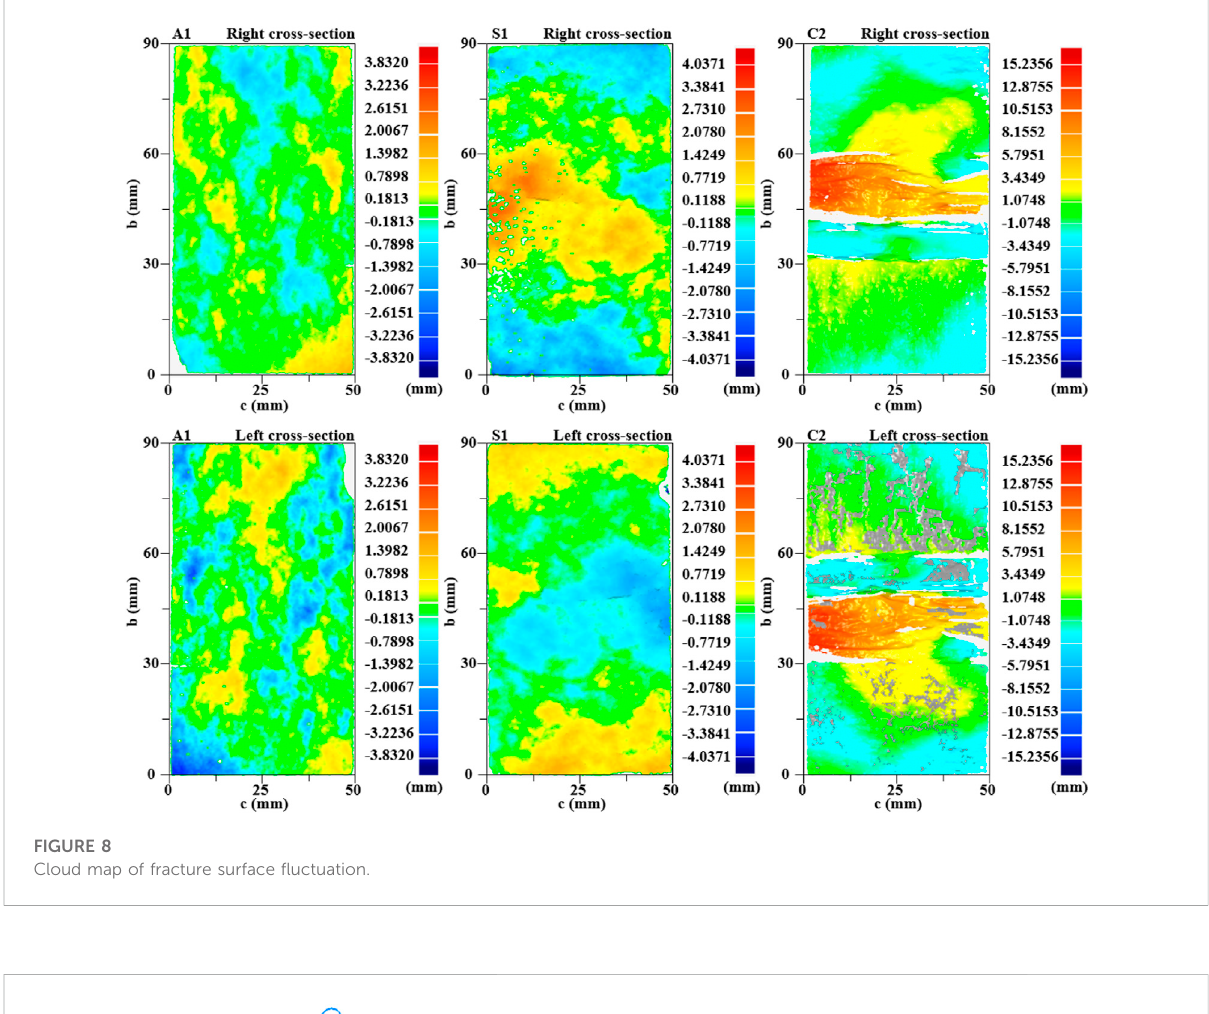
FIGURE 8 Cloud map of fracture surface fl uctuation.